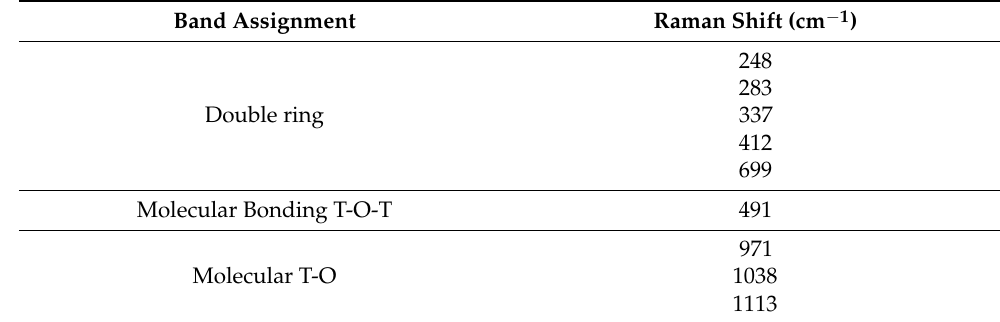
Figure 6. The image shows the Raman spectrum of zeolite 5A with its respective characteristic modes, and the inset shows the optical image of the sample. Table 3. Active vibrational modes identified for zeolite